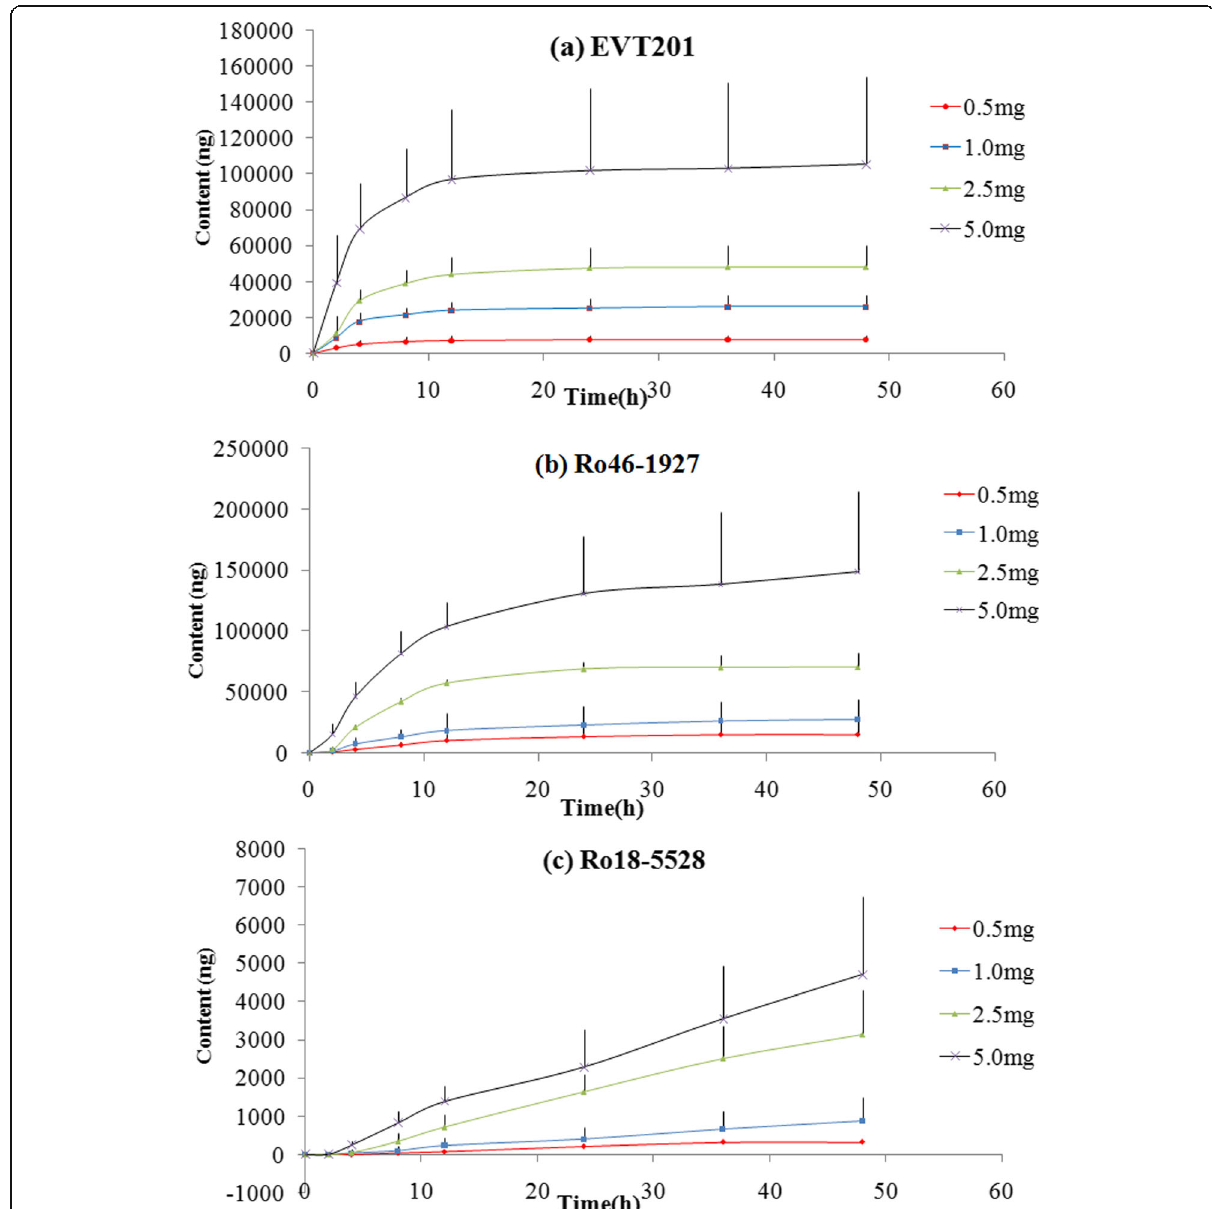
Fig. 4 Representative drug excretion profiles after a single dose of oral administration (dosage of EVT201: 0.5, 1.0, 2.5, and 5